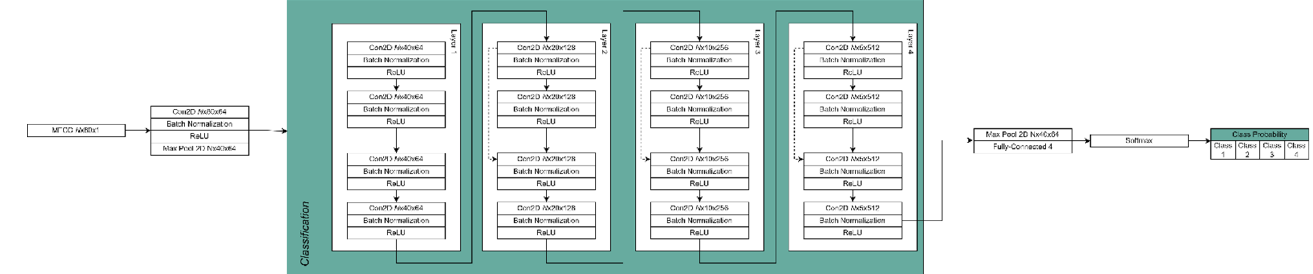
Figure 9. The architecture of the hybrid deep neural network used for classification.